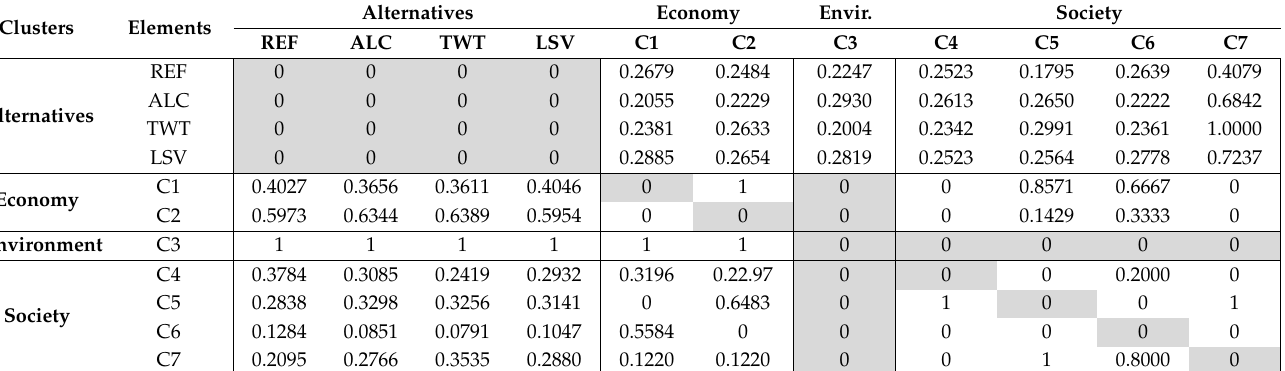
Table 6. Unweighted supermatrix from DM